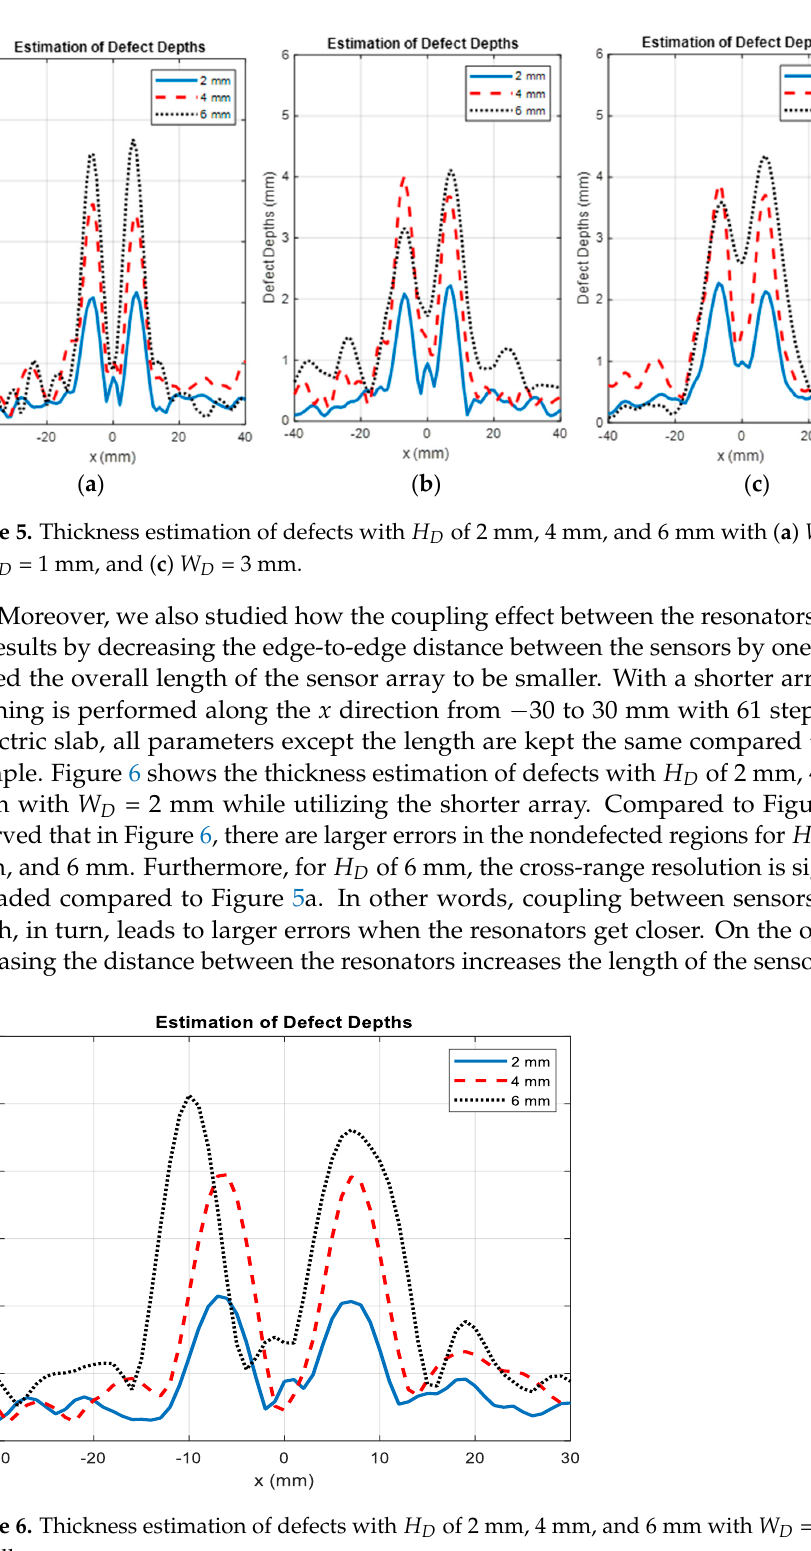
Figure 5. Thickness estimation of defects with 𝐻 𝐷 of 2 mm, 4 mm, and 6 mm with ( a ) 𝑊 𝐷 = 2 mm, ( b ) 𝑊 𝐷 = 1 mm, and ( c ) 𝑊 𝐷 = 3 mm.